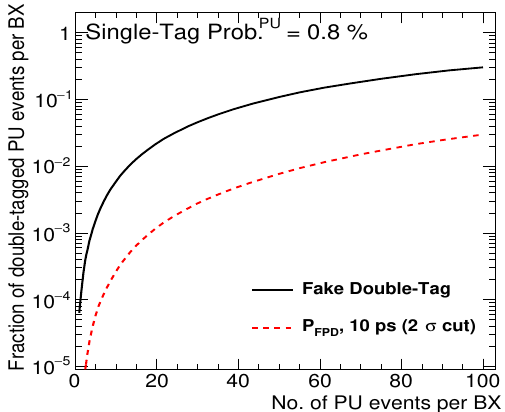
Figure 2 . Fractions of fake DT events in one bunch crossing (BX) and overall rejection probabilities P FPD , including ToF discrimination, as a function of (cid:22) . The results are based on a ST probability of 0.008 for MB events generated by Pythia 8.2 and on a ToF resolution of 10 ps. Pythia 8.2 Herwig 7.1